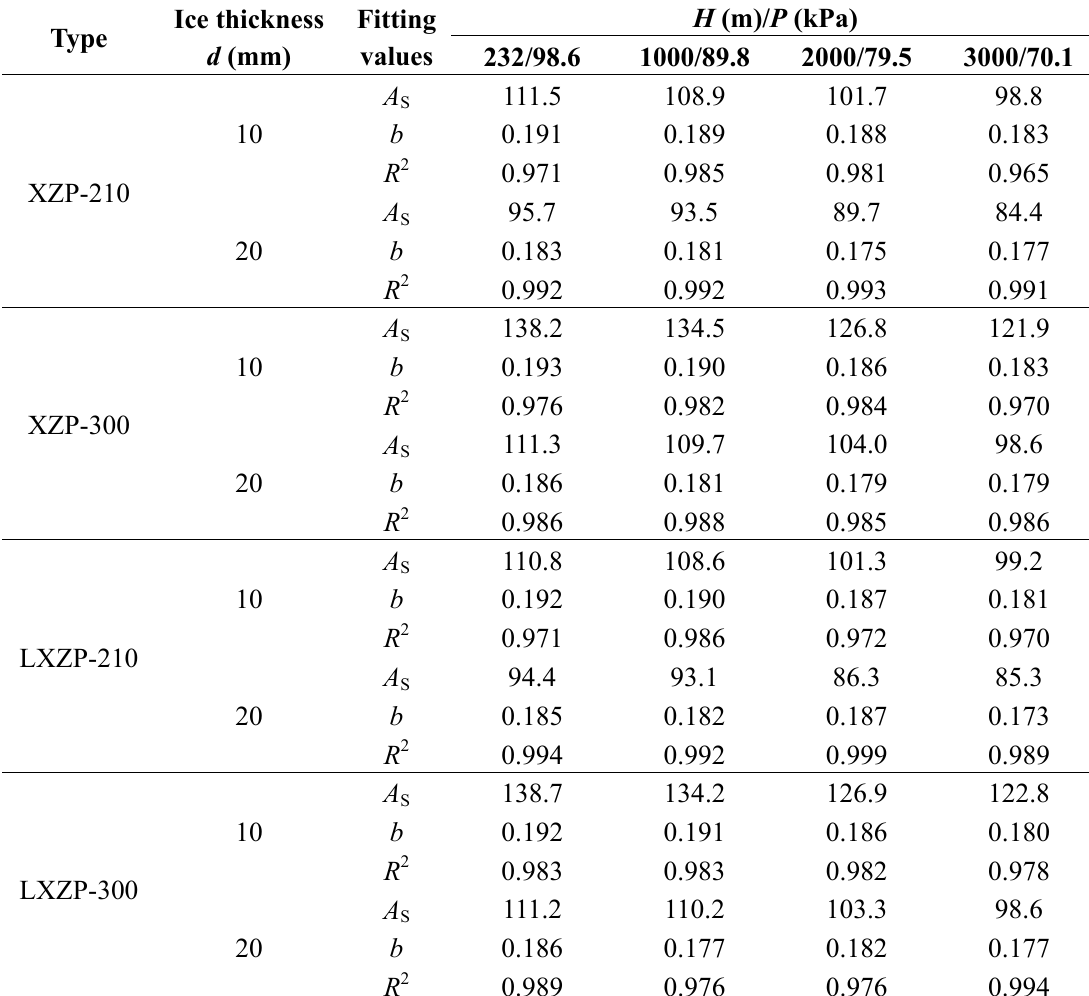
Table 5. Fitting values of A Equation